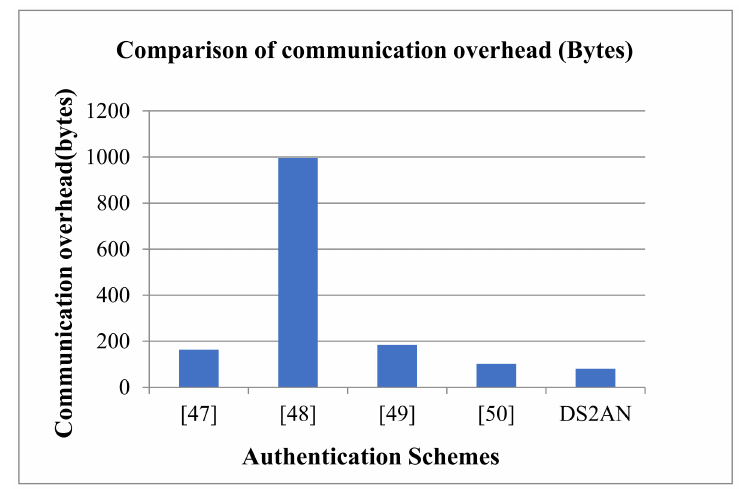
Figure 12. Communication overhead comparison.